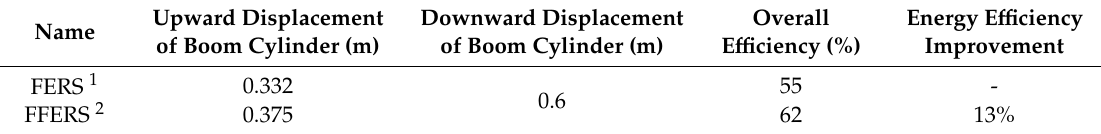
Figure 23. Energy stored in the flywheel at di ff erent PM displacements. Table 6. Comparison of energy e ffi ciencies of the FERS and